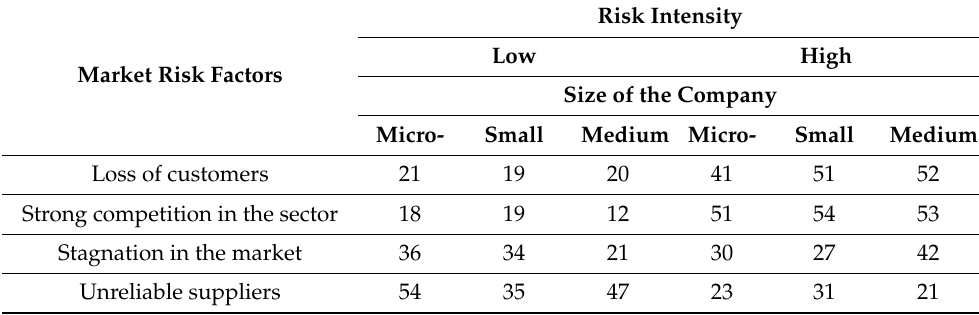
Market Risk Factors